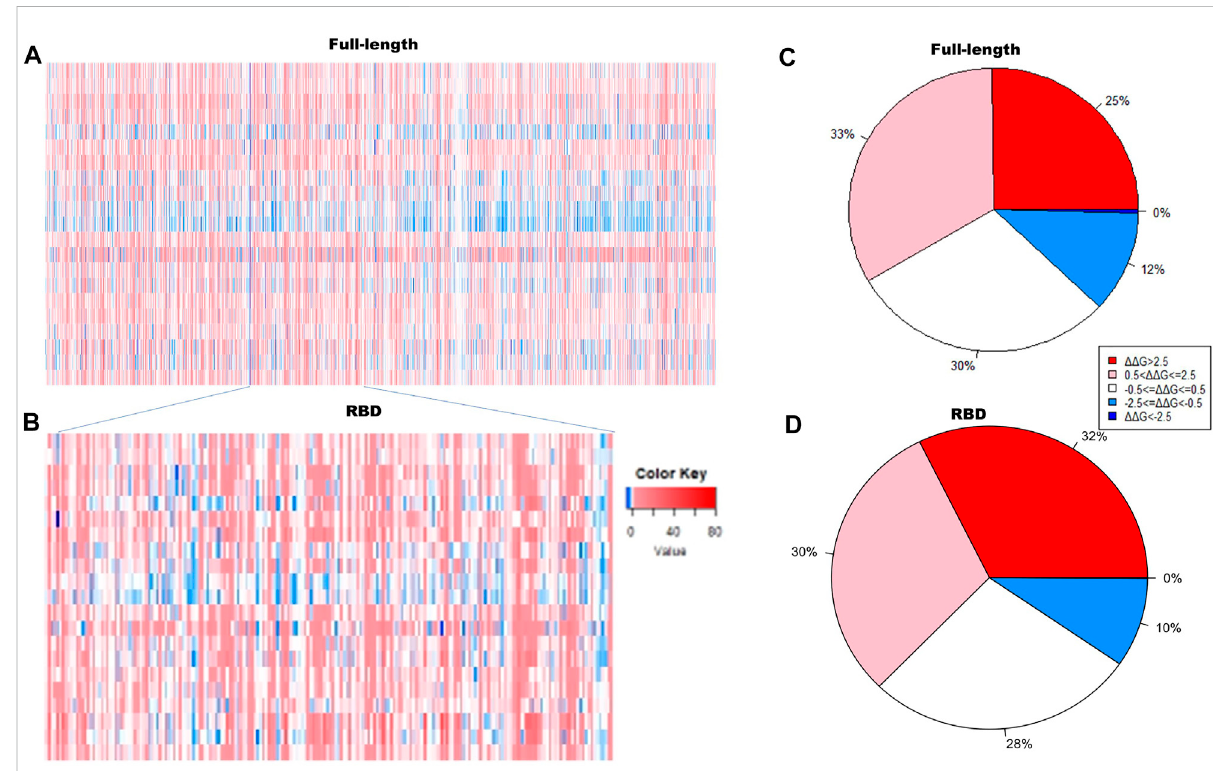
FIGURE 1 Stability heatmaps of the full-length (A) and the receptor-binding domain (B) MERS-CoV S protein. The pie charts represent the distribution of predictionsoffreefoldingenergyfollowingmutagenesisofthe (C) full-lengthMERS-CoVSproteinandthe (D) receptor-bindingdomain(RBD)ofthe MERS-CoV S